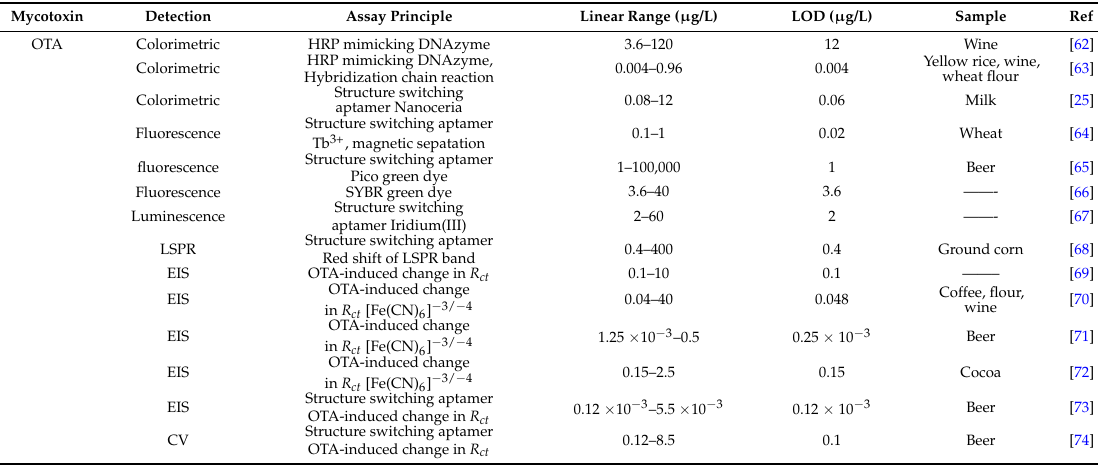
Table 2. Label-Free aptasensors for mycotoxin determination in food reported in the literature.